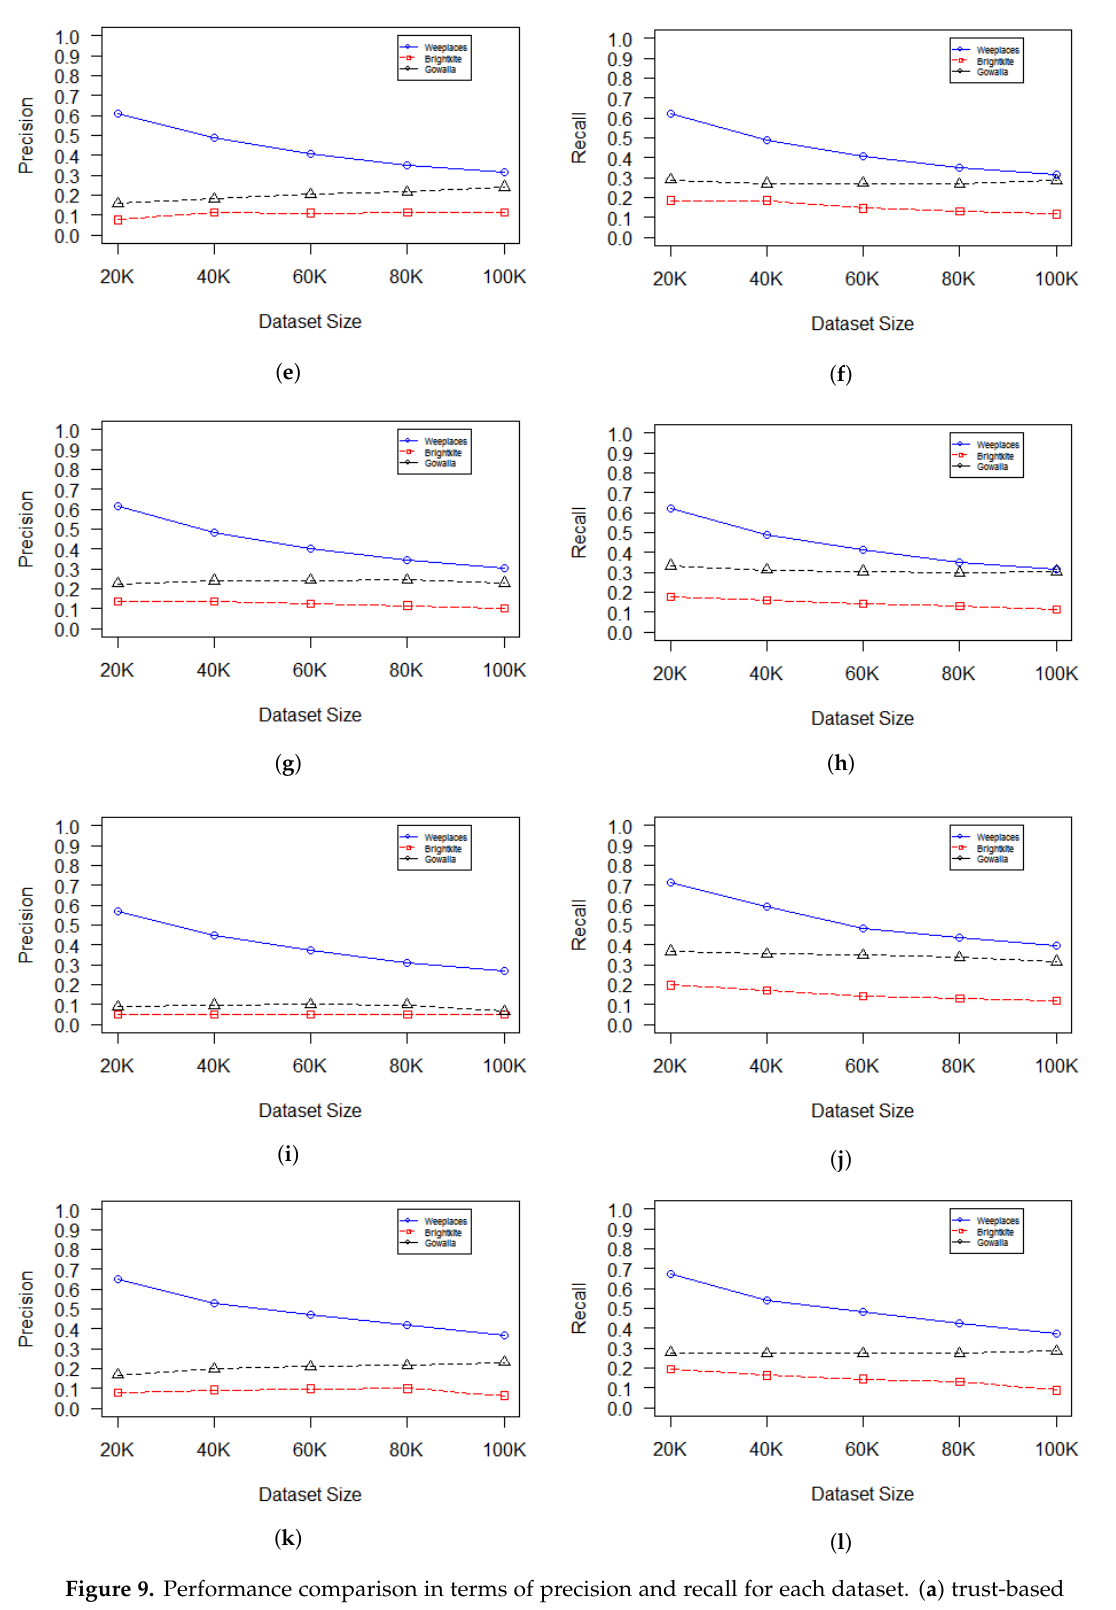
Figure 9. Performance comparison in terms of precision and recall for each dataset. ( a ) trust-based algorithm (TBA) precision; ( b ) trust-based algorithm (TBA) recall; ( c ) closeness centrality measure (CCM) precision; ( d ) closeness centrality measure (CCM) recall; ( e ) betweenness centrality measure (BCM) precision; ( f ) betweenness centrality measure (BCM) recall; ( g ) degree centrality measure (DCM) precision; ( h ) degree centrality measure (DCM) recall; ( o ) K-Core precision; ( j ) K-Core recall; ( k ) local centrality with a coefficient (CLC) precision; ( l ) local centrality with a coefficient (CLC)